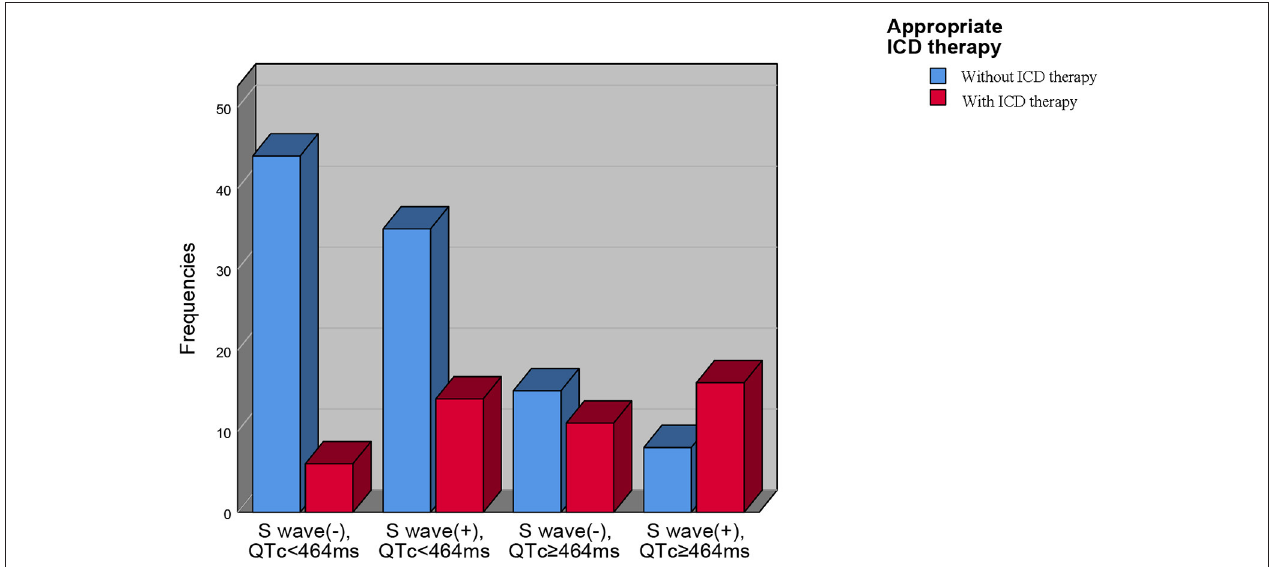
FIGURE 4 | The prevalence of appropriate ICD therapies in four subgroups based on QTc interval and V4-S wave. ICD, implantable